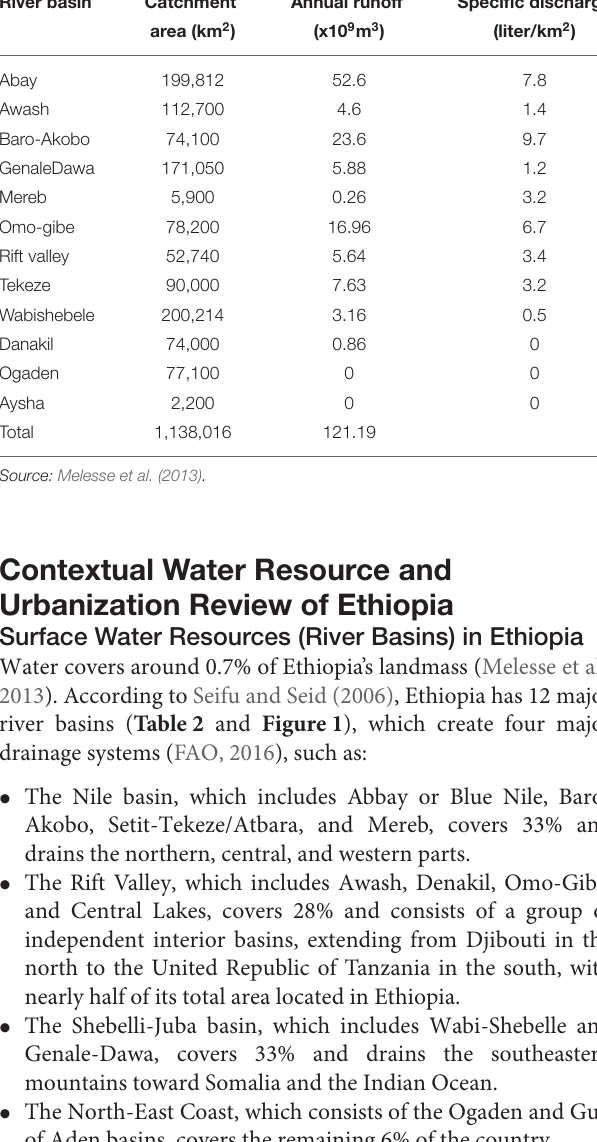
TABLE 2 | Ethiopian surface water resources by major river basins. River